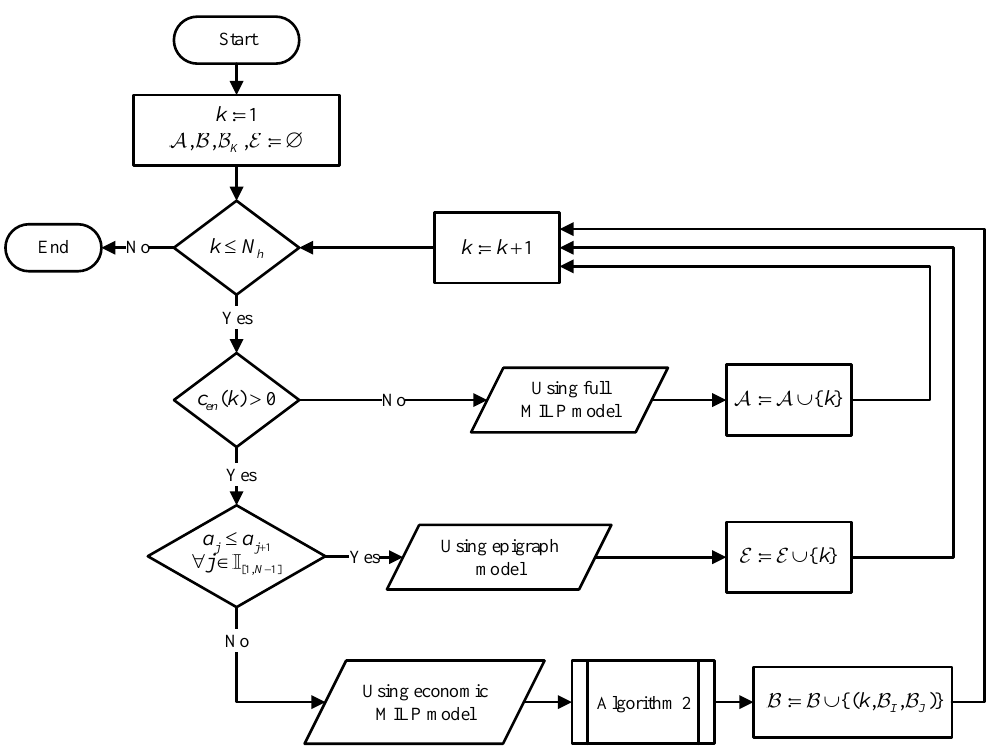
Figure A9. Flowchart to determine approximation method for losses.